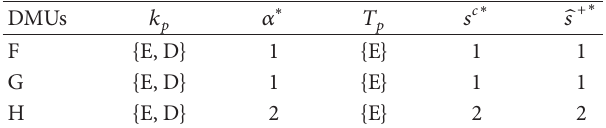
Table 2: Results of Part (b) of the proposed algorithm in Example